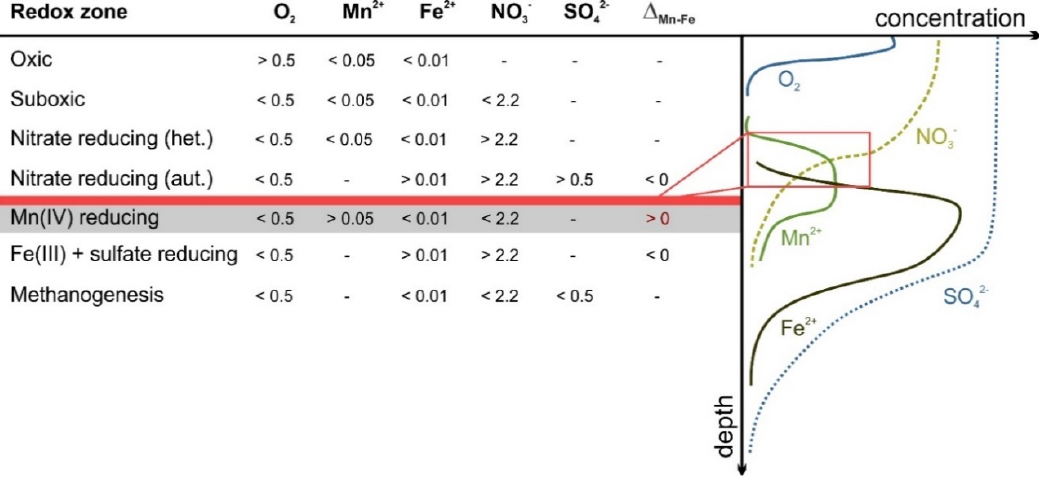
Figure 4. Typical concentration ranges [mg/L] of redox indicator parameters (Christensen et al., 2000 and adapted after Jurgens et al., 2009).